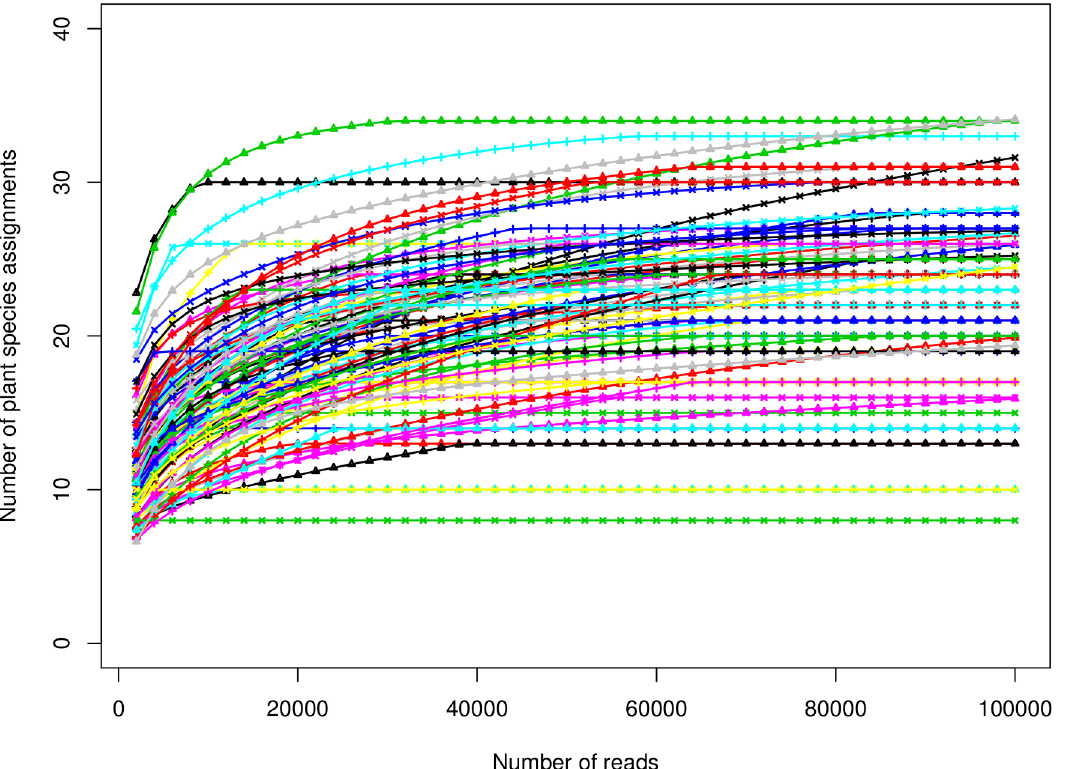
Fig 7. Rarefaction curves for all samples. Only species-level assignments within Viridiplantae are considered, with all other assigned or unassigned counts combined into a single ‘ other ’ bin. Subsamples ranged from 2,000 to 100,000 reads per sample, subject to the limit of actual sample size.